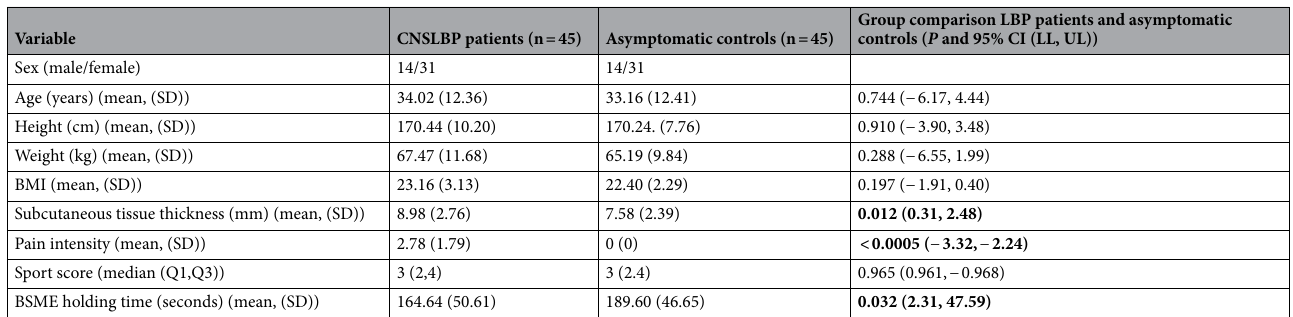
Table 2. Demographic and clinical characteristics of the final sample including group comparison of the chronic non-specific low back pain (CNSLBP) group and asymptomatic controls. Displayed are significance ( P ), 95% confidence intervals (95% CI), lower limit (LL) and upper limit (UL). Significant values are in